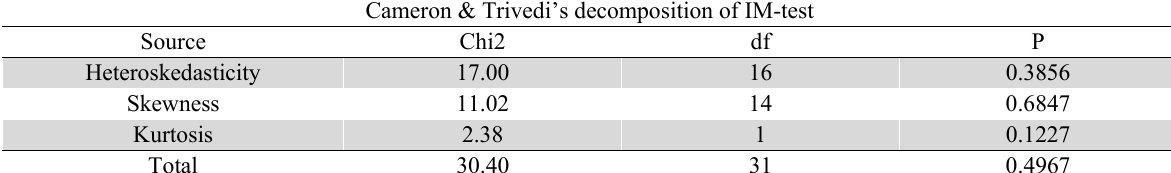
Heteroscedasticity test to the ARDL model (1,2,4,4) White’s test for H0: homoskedasticity against Ha: unrestricted heteroskedasticity Chi2 (16) = 17.00